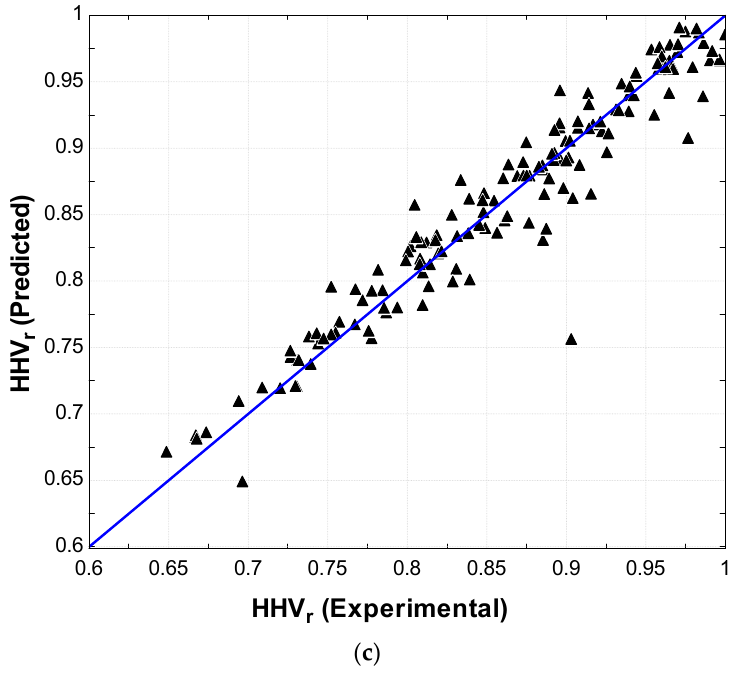
Figure 3. Regression model plot for ( a ) C r ( b ) H r and ( c ) HHV r